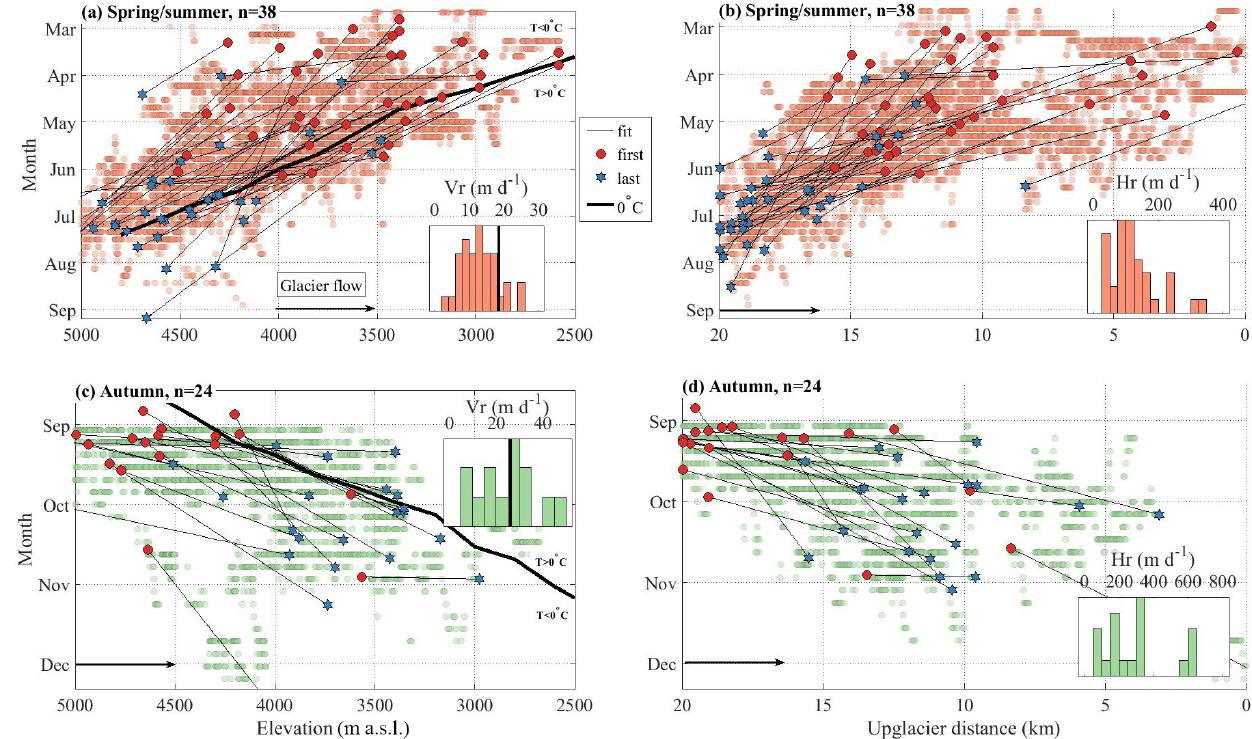
Figure 6. Observed time at which the acceleration starts along the flowline as a function of (a, c) the glacier elevation and (b, d) the upglacier distance for the spring/summer period (a, b) and the autumn period (c, d) . Light orange and green dots show the automatically picked points (as described in Fig. 5), red points show the earliest onset date of the acceleration for each glacier and blue stars show the latest onset date obtained from the fitted line. Gray lines show the fitted migration rate of the acceleration along the flowline for each glacier. Histograms show the distribution of the vertical (Vr) and horizontal (Hr) migration rate. Bold black line in (a) shows the time and elevation at which daily averaged air temperature starts to be positive during the melt season; above this line temperatures are negative and under this line they are positive (Fig. S1). Bold black line in (c) shows the time and elevation at which air temperatures drop to negative values at the end of the melt season; above this line temperatures are positive and under this line they are negative (Fig. S1). Migration rates of these temperature changes with altitude are shown in bold black lines in the